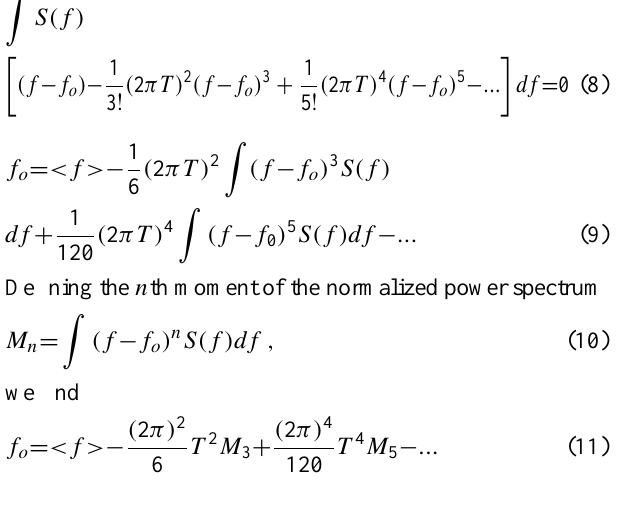
Fig. 2. Phase, φ , vs. time lag (=Lag Number * 200 µ s) for STARE